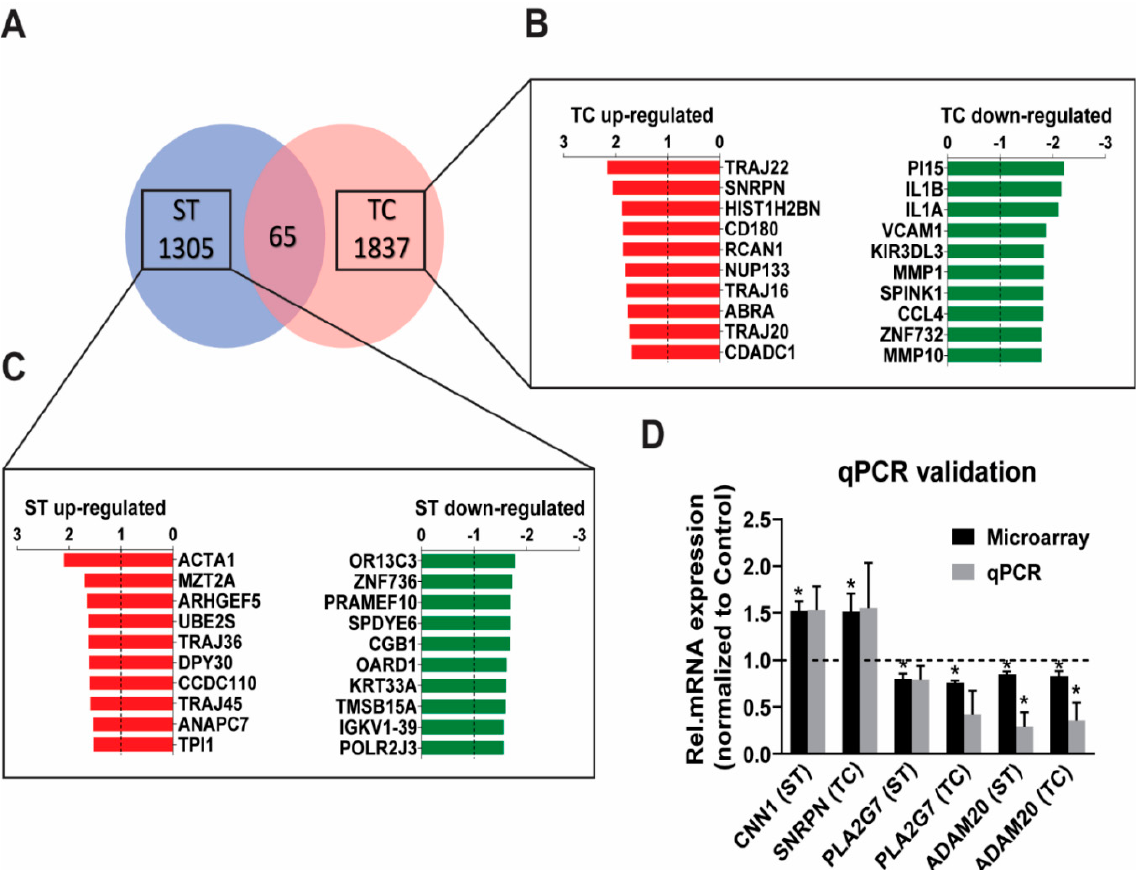
Figure 1. Genome wide expression characterization of stretch (ST) and tachycardia (TC) in human atrial trabeculae. ( A ) Microarray Venn diagram showing all genes regulated by ST or TC with p < 0.05 and fold-change cut-off of at least 1.2-fold up- or − 1.2 down-regulated, n = 5 hearts per group. ( B , C ) A zoom-in of the top 10 genes (only protein coding ones) up-regulated (red) or down-regulated (green) after 6h of either stretch or tachycardia stimulation. ( D ) qPCR validation of some of the strongest regulated protein coding microarray genes with a determined function. Statistical difference determined by one-sample t -test. * p < 0.05, n = 4–5 hearts per group. Despite the predominantly independent gene regulation between stretch and tachy- cardia, there were 65 transcripts that were commonly regulated by both triggers (Figure 2A): The larger fraction (39 genes) displayed unidirectional regulation (Figure 2B) while the smaller fraction (26 genes) was regulated in opposite direction (Figure 2C) between both triggers. The majority of the common genes with identical direction were up-regu- lated in their expression. Among characterized transcripts with a known biological func- tion a microRNA encoding transcript, MIR1183 , had the highest expression level. In con- trast, MIR4501, ADAM20, and PLA2G7 were the most down-regulated common tran- scripts. A complete list of all significantly regulated transcripts and all 65 commonly reg- ulated transcripts is provided in the Supplementary Table S1. Bioinformatic estimations via ingenuity pathway analysis (IPA) provided infor- mation on molecules and associated networks, canonical pathways, disease and functions, upstream regulators, and causal networks which are summarized in Supplementary Table S2. By these means we also determined potential upstream regulators of the affected target